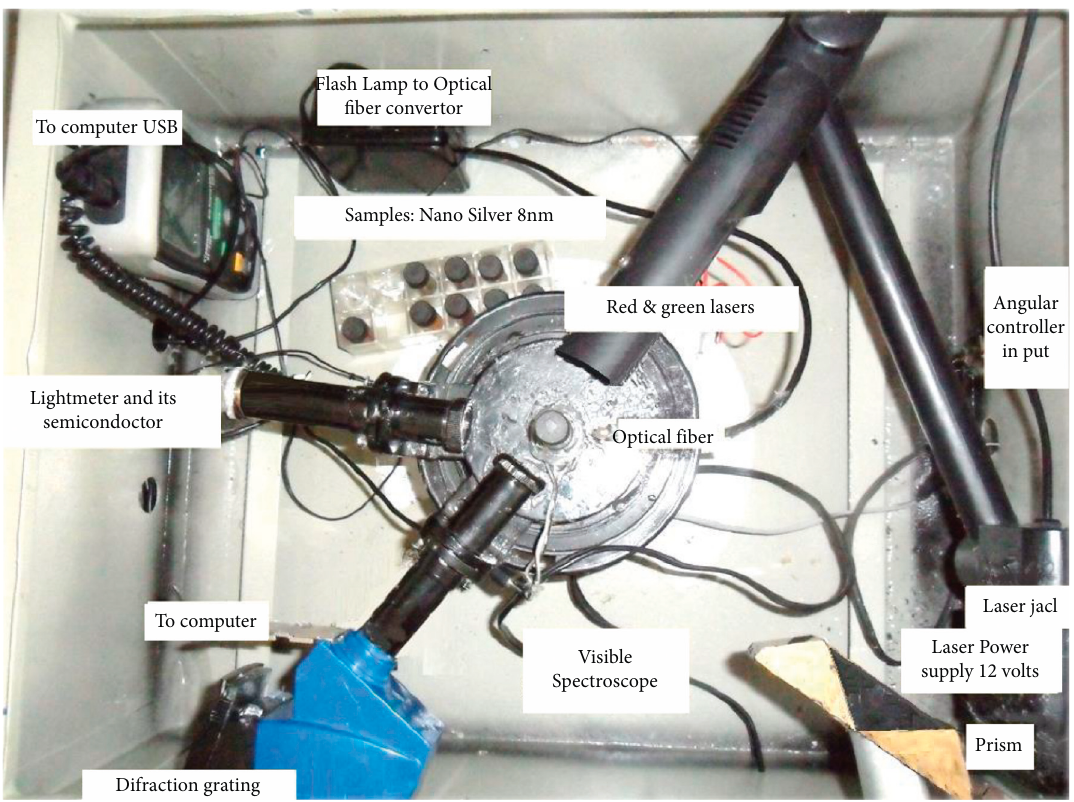
Figure 4: The 5th and most advanced device to date; it features a white LED light and lasers in green and red